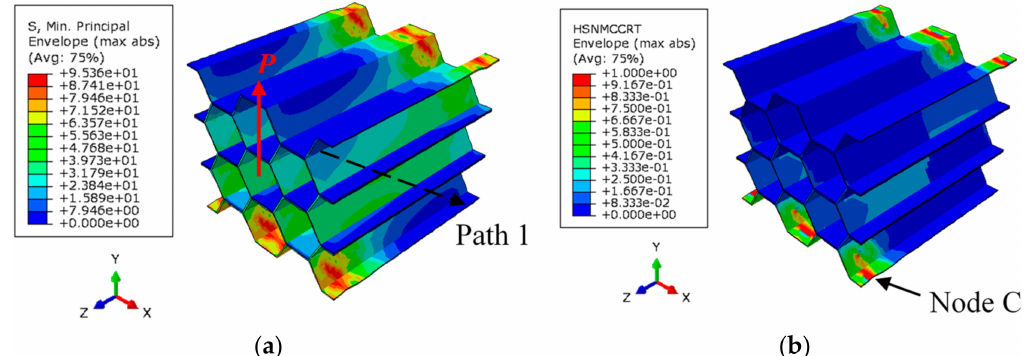
Figure 16. ( a ) Minimum principal (compressive) stress, and ( b ) matrix compressive damage contour, corresponding to the applied shear displacement of 0.33